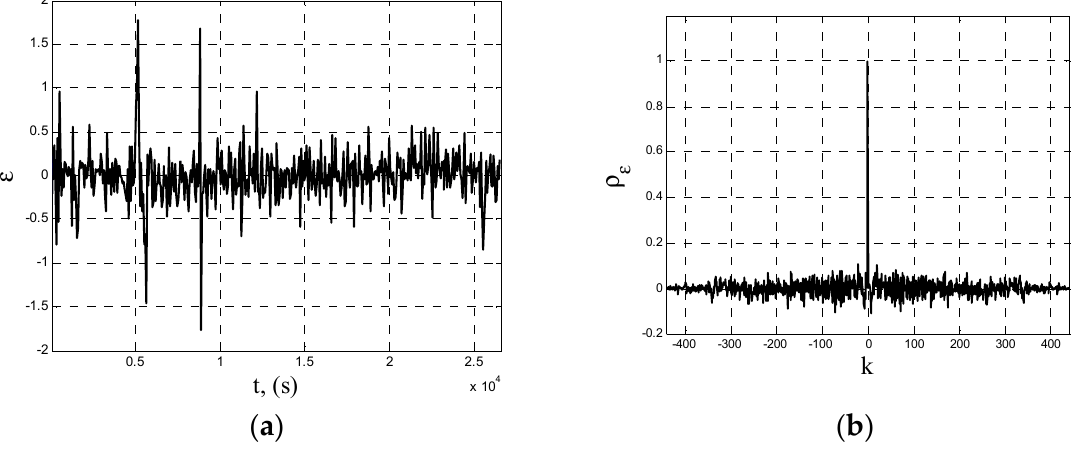
Figure 8. Evaluation of the ARMA model residuals with parameters (20): ( a ) course of the residuals, ( b ) standardised